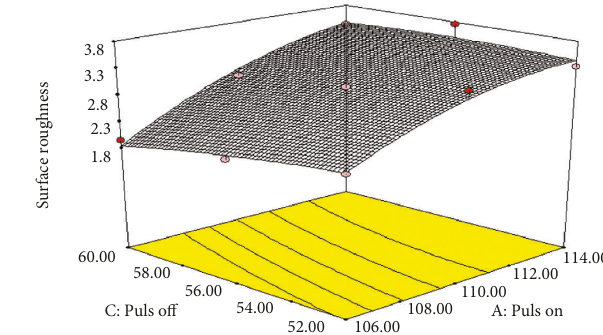
Figure 14: Effect on the PT